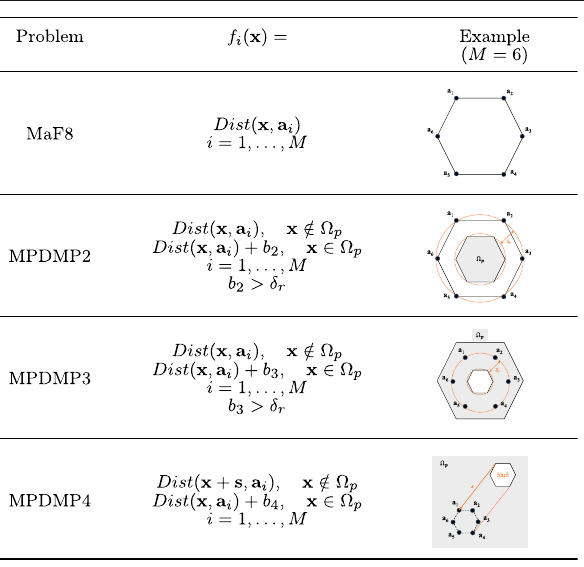
Table 2 Definition of the multi-point distance minimization problems